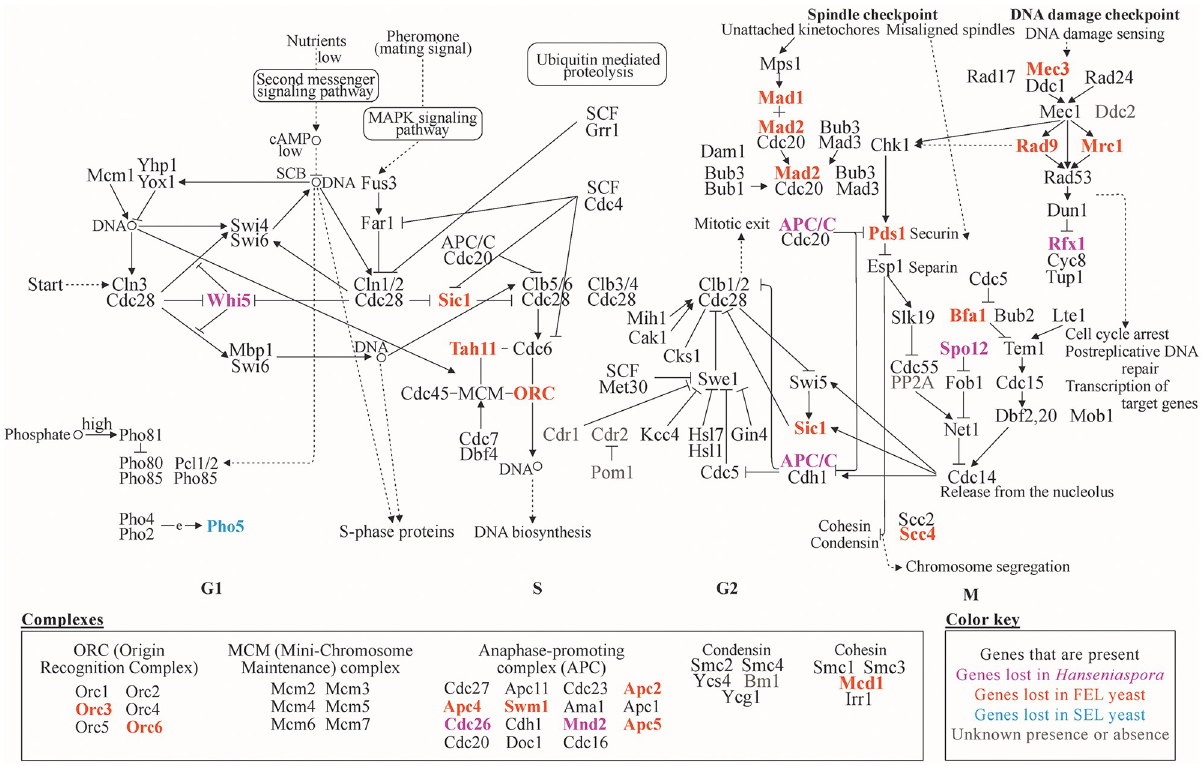
Fig 3. Gene presence and absence in the budding yeast cell cycle. Examination of cell-cycle genes revealed numerous genes that are absent in Hanseniaspora genomes. The genes not present in Hanseniaspora participate in diverse functions and include key regulators such as WHI5 , components of spindle checkpoint processes and segregation such as MAD1 and MAD2 , and components of DNA-damage–checkpoint processes such as MEC3 , RAD9 , and RFX1 . Genes absent in both lineages, the FEL, or the SEL are colored purple, orange, or blue, respectively. The “e” in the PHO cascade represents expression of Pho4:Pho2. Dotted lines with arrows indicate indirect links or unknown reactions. Lines with arrows indicate molecular interactions or relations. Circles indicate chemical compounds such as DNA. figshare: https://doi.org/10.6084/m9.figshare.7670756.v2. Ama, Activator of meiotic anaphase-promoting complex; APC (or APC/C), Anaphase-Promoting Complex; Bfa, Byr-four-alike; Bm1, Biomimetic moiety glutathionesulfonic acid; Bub, Budding uninhibited by benzimidazole; Cak1, Cyclin-dependent kinase-activating kinase; cAMP, cyclic AdenosineMonoPhosphate; Cdc, Cell division cycle; Cdh, CDC20 homolog; Cdr, Candida drug resistance; Chk, Checkpoint kinase; Cks, Cdc28 kinase subunit; Clb, Cyclin B; Cln, Cyclin; Cyc, Cytochrome C; Dam, Duo1 and Mps1 interacting; Dbf, Dumbbell former; Ddc, DNA Damage Checkpoint; Doc, Destruction of Cyclin B; Dun, DNA-damage UNinducible; Esp1, Extra spindle pole bodies 1; Far1, Factor ARrest; FEL, faster-evolving lineage; Fob, Fork Blocking less; Fus3, cell fusion 3; Gin4, Growth inhibitory 4; Grr, Glucose repression-resistant; Hsl, Histone synthetic lethal; Irr, Irregular cell behavior; Kcc, K + -Cl − cotransporters; Lte, Low temperature essential; MAD , Mitotic Arrest-Deficient; MAPK, Mitogen-Activated Protein Kinase; Mbp, Mlul-box–binding protein; Mcd, Mitotic chromosome determinant; MCM, Mini-Chromosome Maintenance; MEC3 , Mitosis Entry Checkpoint 3; Met30, Methionine requiring 30; Mih1, Mitotic inducer homolog; Mnd, Meiotic nuclear divisions; Mob, Mps one binder; Mps, Monopolar spindle; Mrc, Mediator of the Replication Checkpoint; Net, Nucleolar silencing establishing factor and telophase regulator; ORC, Origin Recognition Complex; Pds, Precocious Dissociation of Sisters; PHO, PHOsphate; Pom, Polarity misplaced; PP2A, Protein Phosphatase 2A; RAD9 , RADiation sensitive; RFX1 ,; SCB, Swi4,6-dependent cell ycle box; Scc, Sister Chromatid Cohesion; SCF, S-phase kinase-associated protein, Cullin, F-box containing complex; SEL, slower-evolving lineage; Sic, Sucrose NonFermenting; Slk, Synthetic lethal karyogamy; Smc, Stability of minichromosomes; Spo, Sporulation; Swe, Saccharomyces Wee1; Swi, Switching deficient; Swm, Spore Wall Maturation; Tah11, Topo-A Hypersensitive; Tem, Termination of M phase; Tup, deoxythymidine monophosphate-uptake; WHI5 , WHIskey 5; Ycg, Yeast cap G; Ycs, Yeast condensing subunit; Yhp1, Yeast Homeo-Protein 1; Yox1, Yeast homeobox